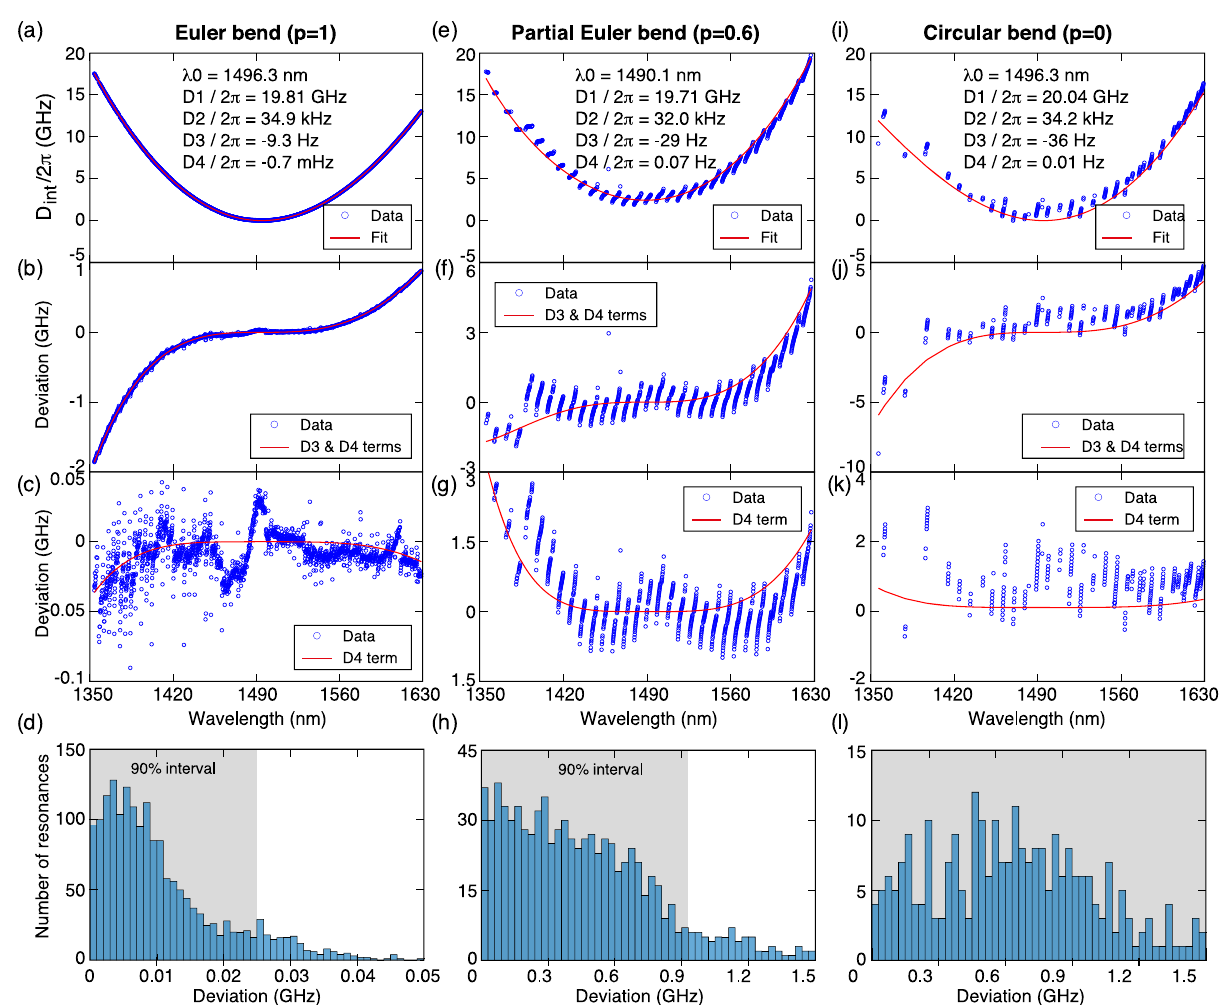
Fig. 3 Integrated dispersion characterization of racetrack microresonators with different bends. The measured integrated microresonator dispersion fi tted with D μ ) = D μ 2 /2 + D μ 3 /6 + D μ 4 /24, the resonance frequency deviations from D int ( 2 3 4 frequency deviations from the D 4 μ 4 /24 curve, for the racetrack microresonators with Euler bends (Euler portion factor p = 1) ( a , b , c , d ), partial Euler bends ( p = 0.6) ( e , f , g , h ), and circular bends ( p = 0) ( i , j , k , l ). Values of each dispersion terms are marked in ( a , e , i ). λ 0 denotes the wavelength of μ = 0 mode. Grey-shaded areas in ( d , h , l ) mark the 90%